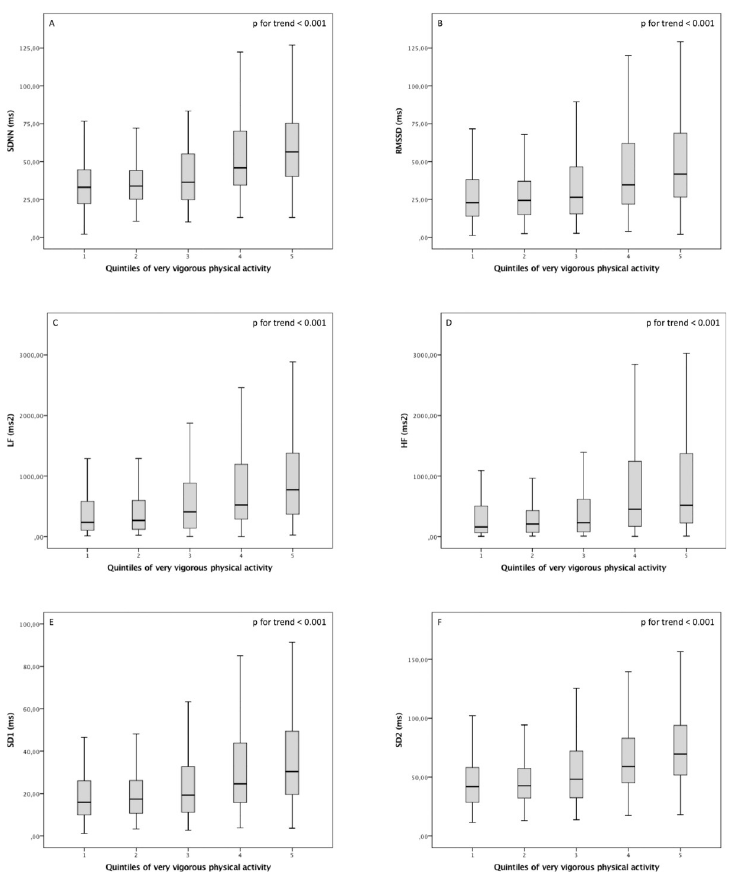
Fig 2. The linear trend of heart rate variability indices across the very vigorous physical activity quintiles in min/ week: group 1, � 1.50; 2, 1.51–3.16; 3, 3.17–3.54; 4, 3.55–20.75; and 5, > 20.75. SDNN (A): the standard deviation of the RR intervals; RMSSD (B): root mean square of RR intervals; LF (C) and HF (D): respectively powers of the low- and high-frequency bands; SD1 (E) and SD2 (F): respectively perpendicular and along with regression line of the Poincare´ plot standard